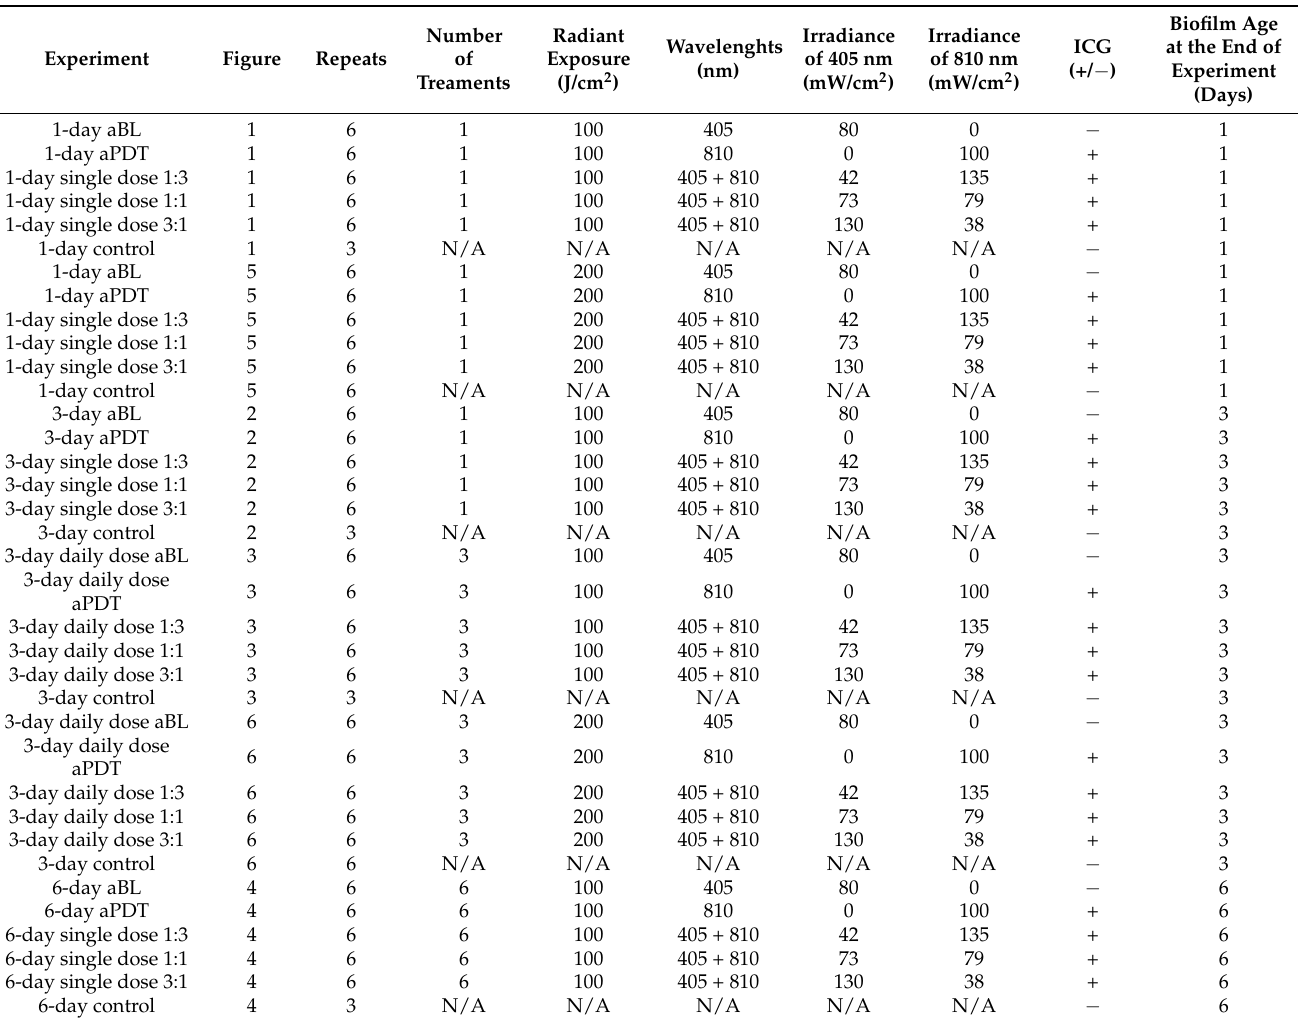
Table 1. Exact details of the test